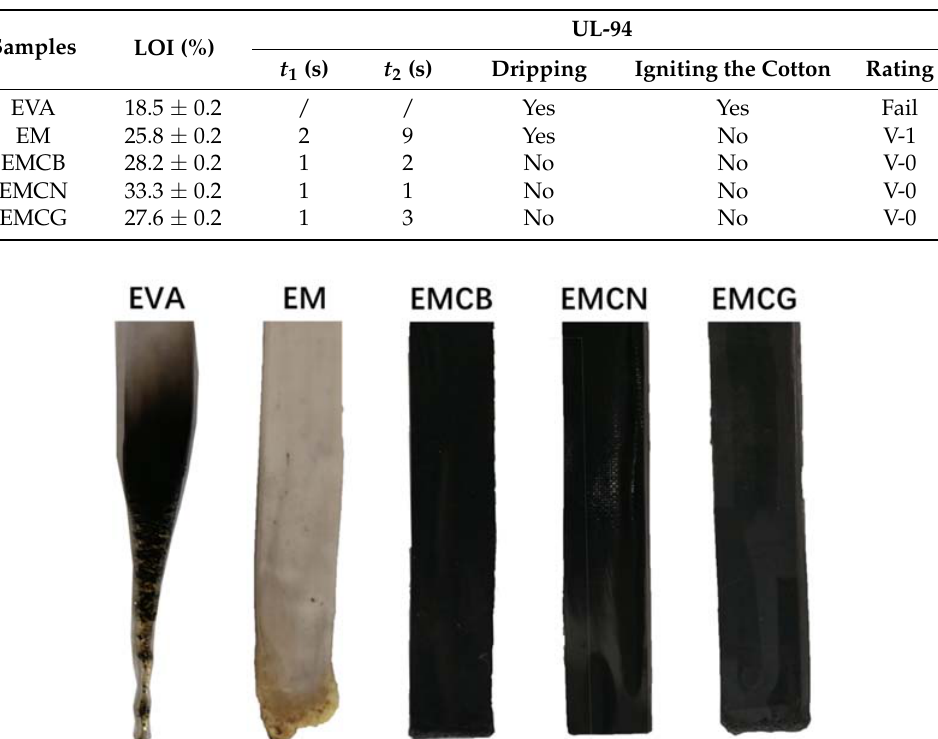
Table 3. Limiting oxygen index (LOI) and UL-94 results.